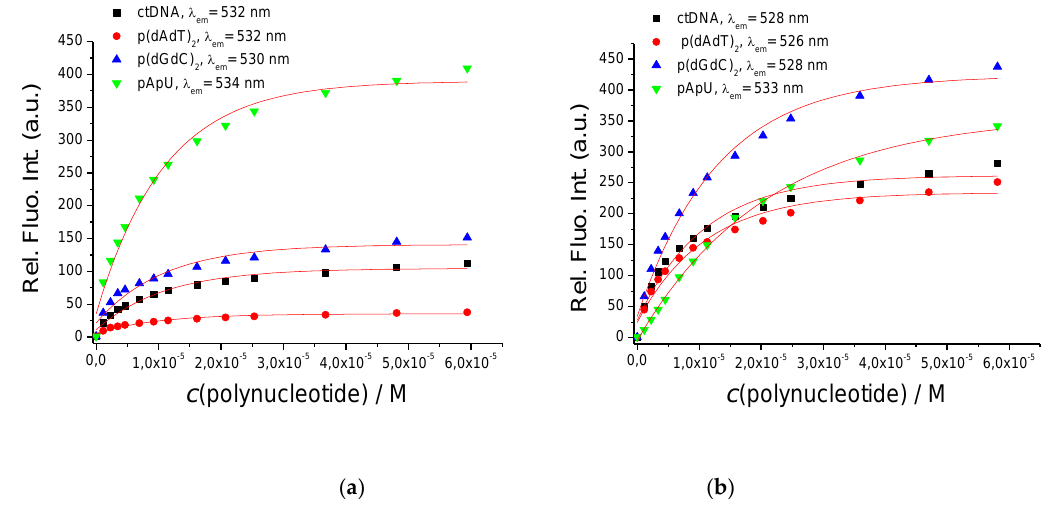
Figure 2. Changes in fluorescence of: ( a ) 1 ( λ exc = 505 nm, c = 5 × 10 − 7 M) or ( b ) 2 ( λ exc = 505 nm, c = 5 × 10 − 7 M); upon addition of polynucleotides. Done at pH 7.0; sodium cacodylate buffer, I = 0.05 M.